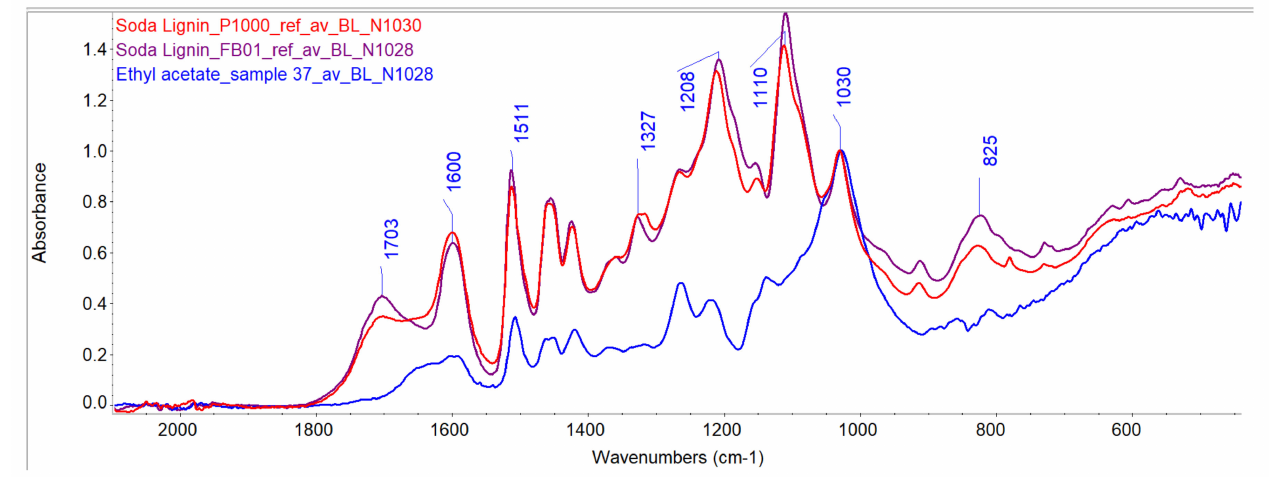
Figure 11. Comparing lignins to ethyl acetate-treated archaeological wood (nr. 37). Infrared spectra of lignin P1000 (red curve), FB01 (purple curve) and of wood (blue curve) were baseline corrected and normalized at 1028 cm − 1 . The band height used to measure extent of penetration of lignins into the wood samples is shown at 1327 cm − 1 .